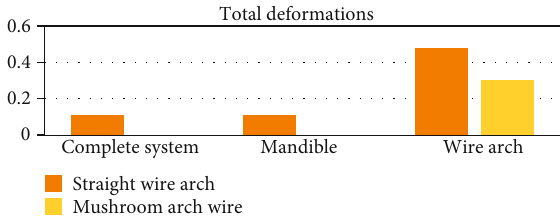
Figure 23: Total deformations (mm). The graph shows a comparison between the deformations that were generated in each of the analyzed sections: complete system (mandibular bone, dental organs, brackets, and wires) and separately the mandible and the two di ff erent types of arches or wires.